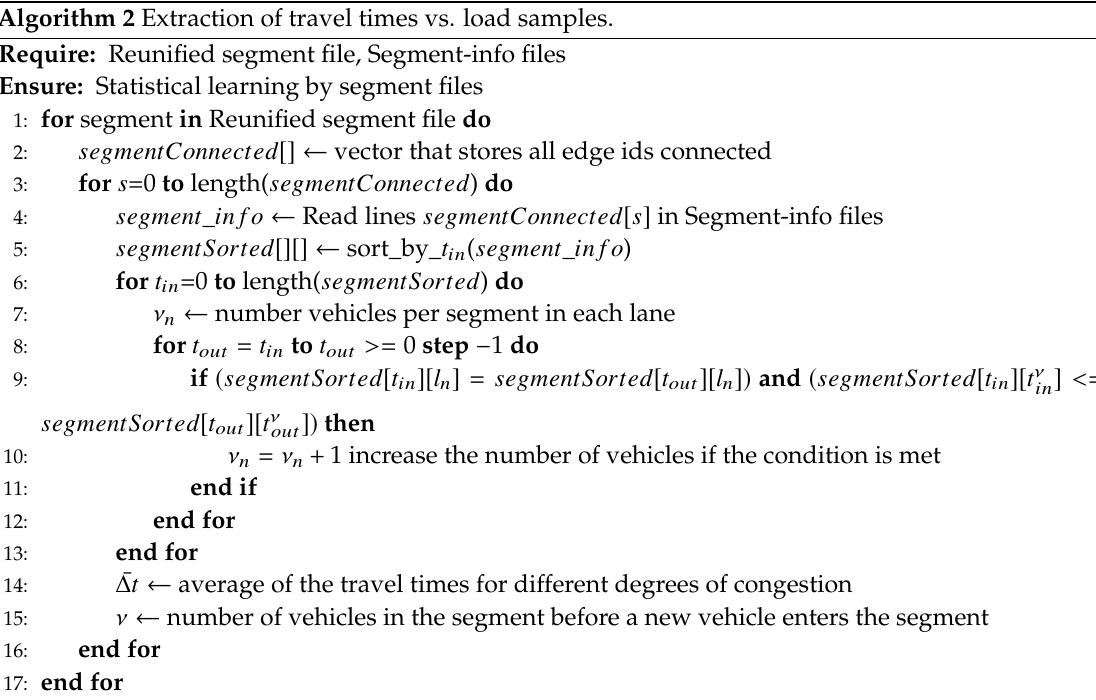
Algorithm 2 Extraction of travel times vs. load